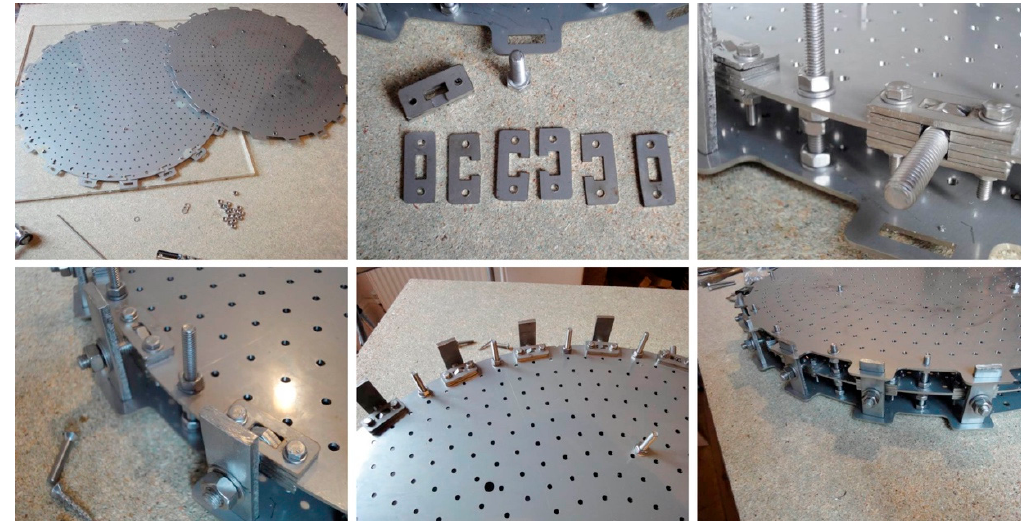
Figure 7. Construction of the improved pin locking mechanism, created using sections of laser-cut shapes layered and bolted together to create a rigid fixing point for the pressure bolts to operate from, (photos: Jorgensen, T. 2012).